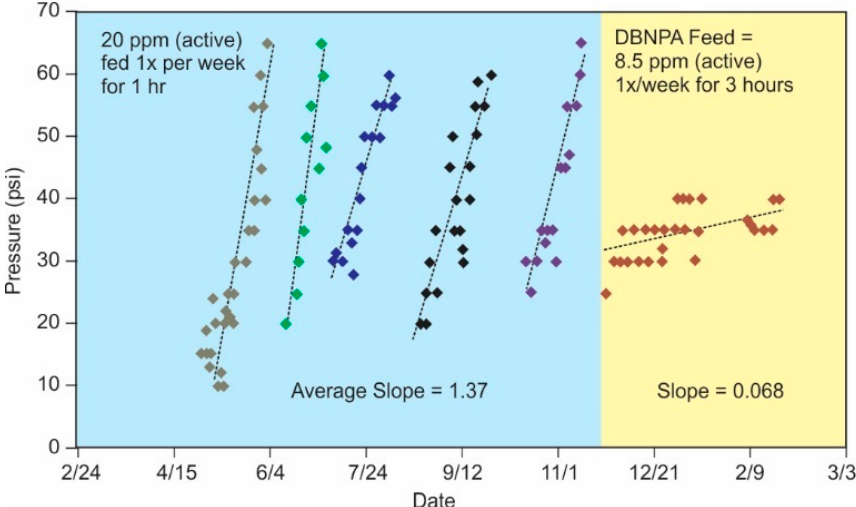
Figure 12. Differential pressure as a function of time for an RO system treated with conventional and a lower-dose, longer-exposure method. Surface water feed form the Weisse Elster River in Germany [93]. Reprinted with permission of the Engineers’ Society of Western Pennsylvania.